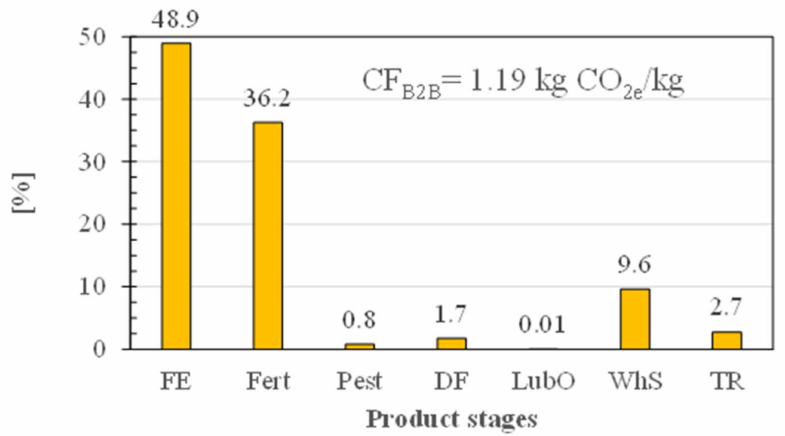
Figure 5. Percentage contribution of the different life cycle product stages to the business-to-business carbon footprint (CF B2B ) of high amylose bread wheat, as well as its overall score: FE, field emis- sions; Fert, fertilizers; Pest, pesticides; DF, diesel fuel; LubO, lubricating oil; WhS, wheat seeds; TR,